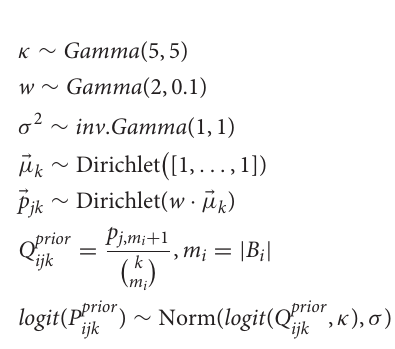
hierarchical Bayesian models for prior and posterior probabilities with parameters as defined by Equation